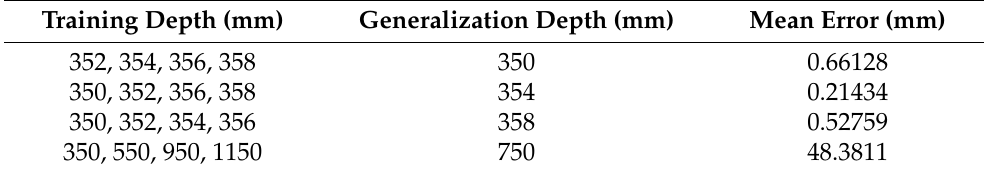
Table 2. Results of depth generalization.